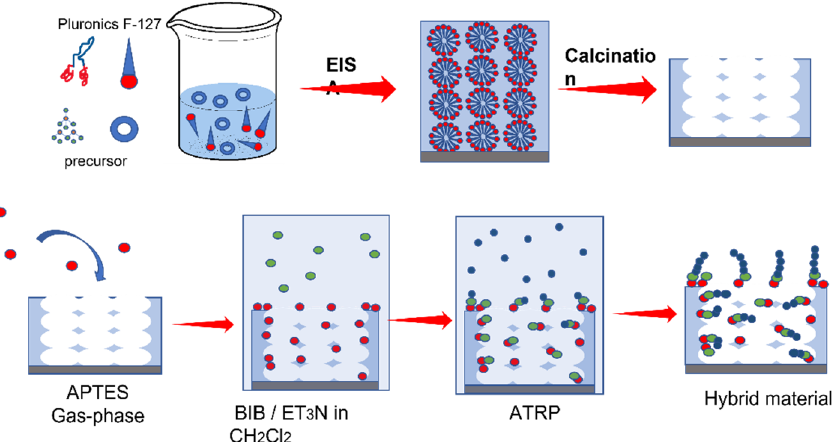
Figure 1. Scheme of the synthesis of the hybrid material. For MTF-TiO 2 , TiCl 4 was used as a precursor, and TEOS was used for MTF-SiO 2 .